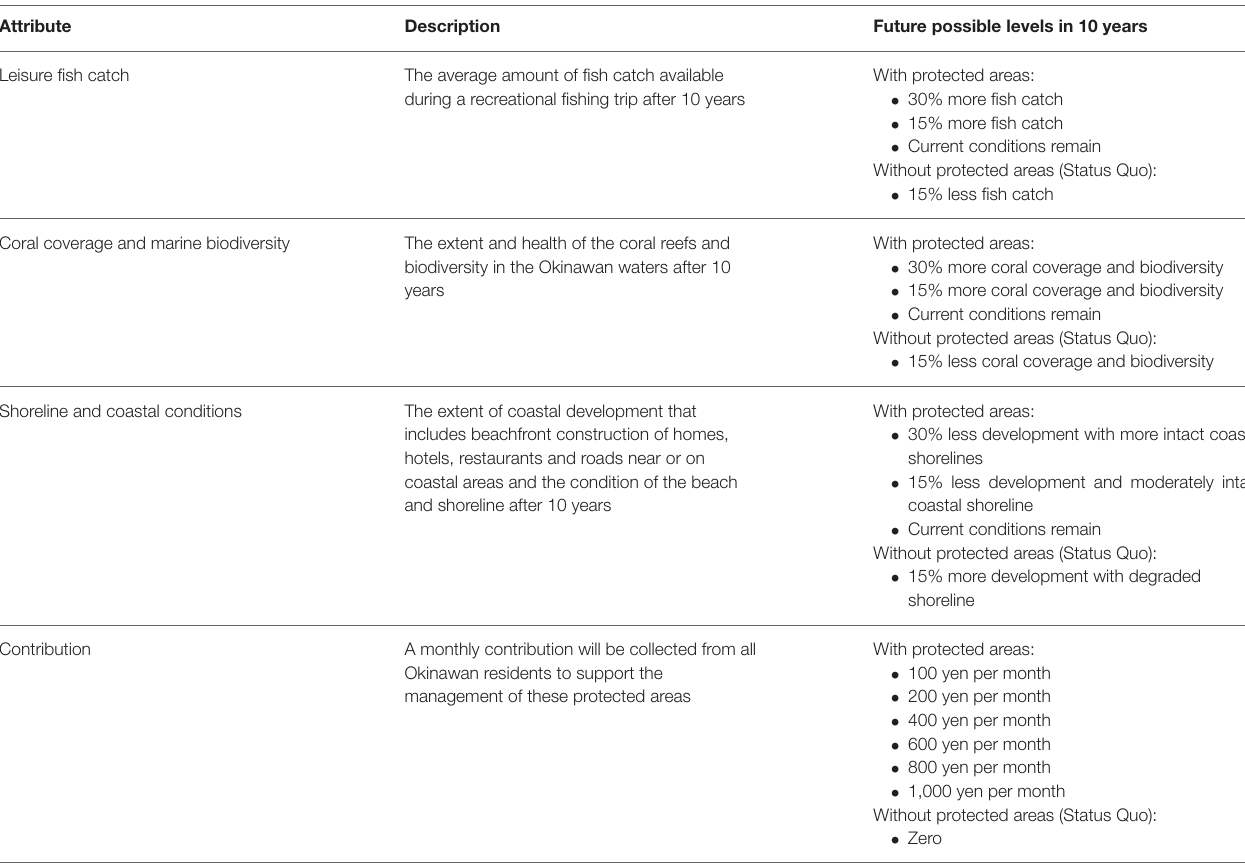
TABLE 1 | Descriptions of attributes and levels used in choice